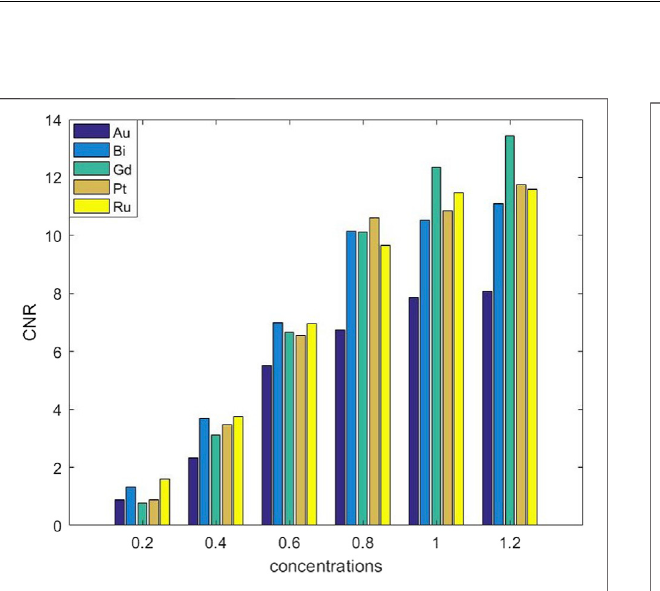
FIGURE 5 | Reconstructed images of different materials by the optimized EM-TV algorithm (iterating 10 times): (A) Pt, (B) Bi, (C) Gd, (D) Ru, and (E) Au.